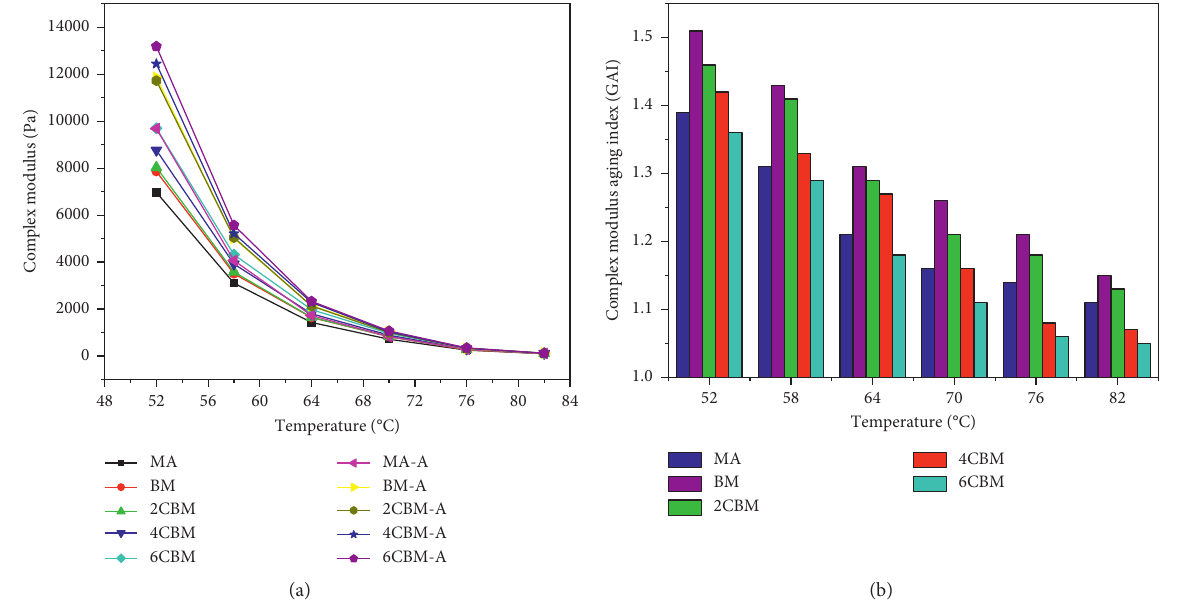
Figure 6: Effect of organic nano-CaCO 3 on rheological properties of bio-asphalt before and after aging. (a) Complex modulus. (b) Complex modulus aging index.